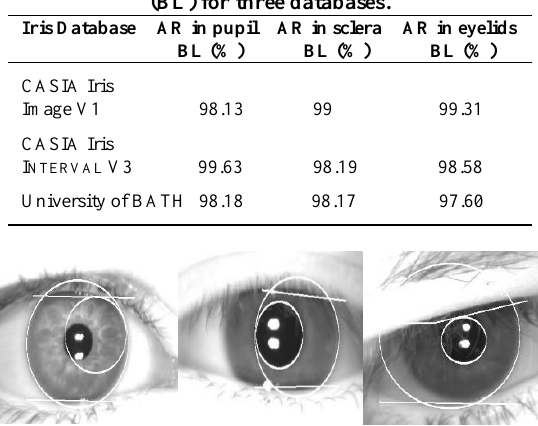
Figure 7. An example where segmentation fails for three eye images from BATH database